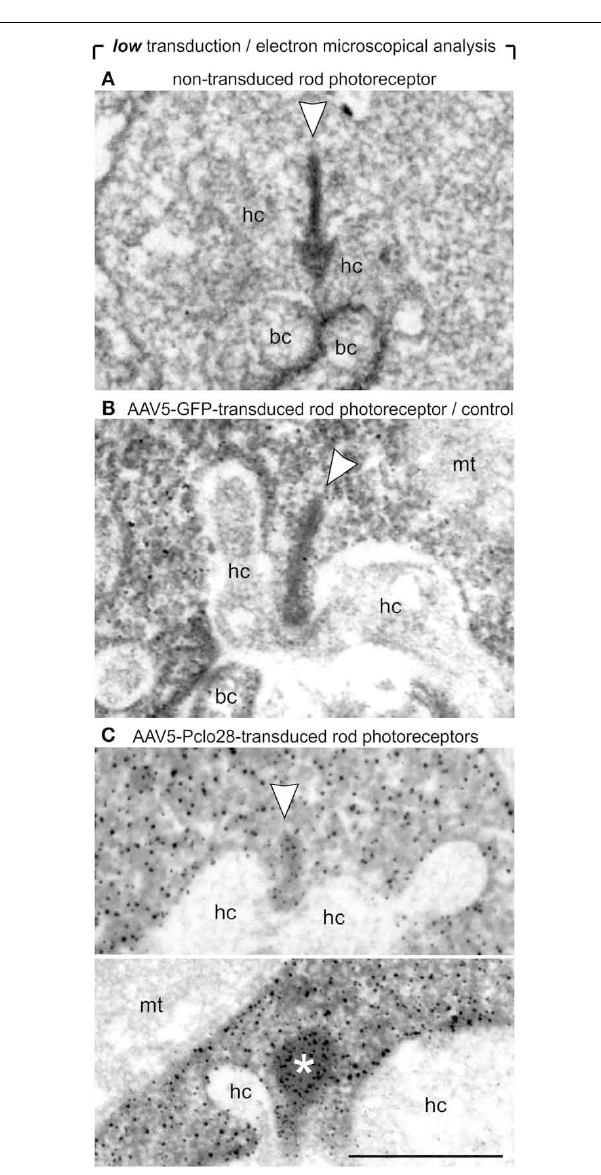
FIGURE 4 | Ultrastructural analysis of C57BL/6 rod photoreceptor ribbon synapses in retinal areas with low AAV5-Pclo28-transduction rates. (A–C) Representative electron micrographs of non-transduced (A) , AAV5-GFP-transduced ( B ; control), and AAV5-Pclo28-transduced (C) rod photoreceptor terminals from retinal areas with low transduction rate. Pre-embedding immunolabeling of GFP in the transduced photoreceptor terminals (B,C) . Arrowheads point to synaptic ribbons, the asterisk demarcates spherical, membrane-associated ribbon material. bc: bipolar cell; hc: horizontal cell; mt: mitochondrion. Scale bar in (C) for (A–C) : 0.5 μ